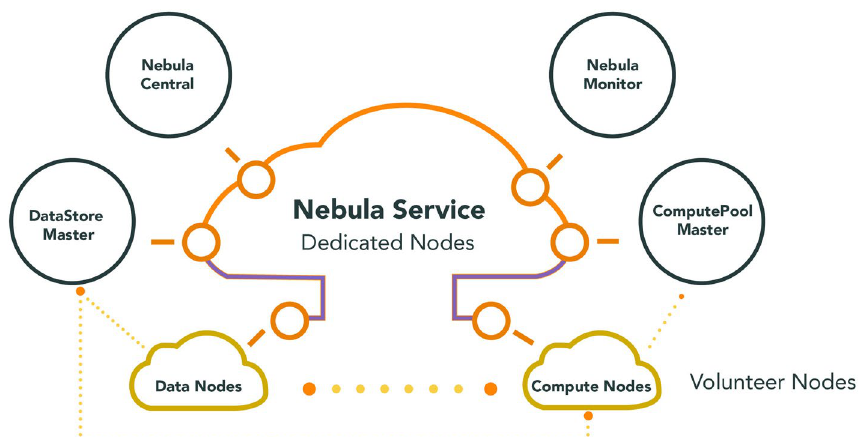
Fig. 3 The designed ‘Nebula Service’ system structure and its connections between ‘Data Nodes’ and ‘Compute Nodes’ as proposed in